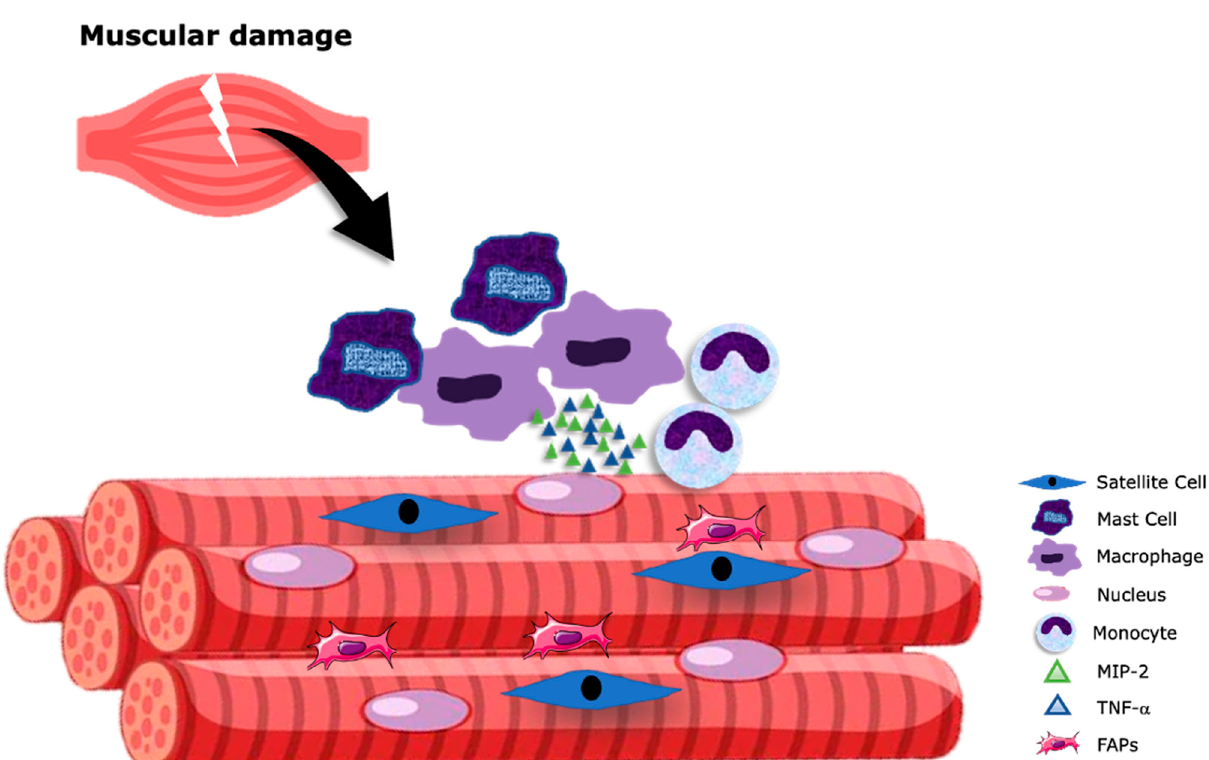
Figure 1. Inflammatory response to muscle damage. After an acute muscular injury, resident cells (mast cells and macrophages) secrete proinflammatory molecules such as tumor necrosis factor alpha (TNF- α ) and macrophage inflammatory protein-2 (MIP-2), promoting neutrophil and monocyte recruitment to the injury region. FAPs: fibroadipogenic precursors. The Figure was partly generated using Servier Medical Art, provided by Servier, licensed under a Creative Commons Attribution 3.0 unported license.